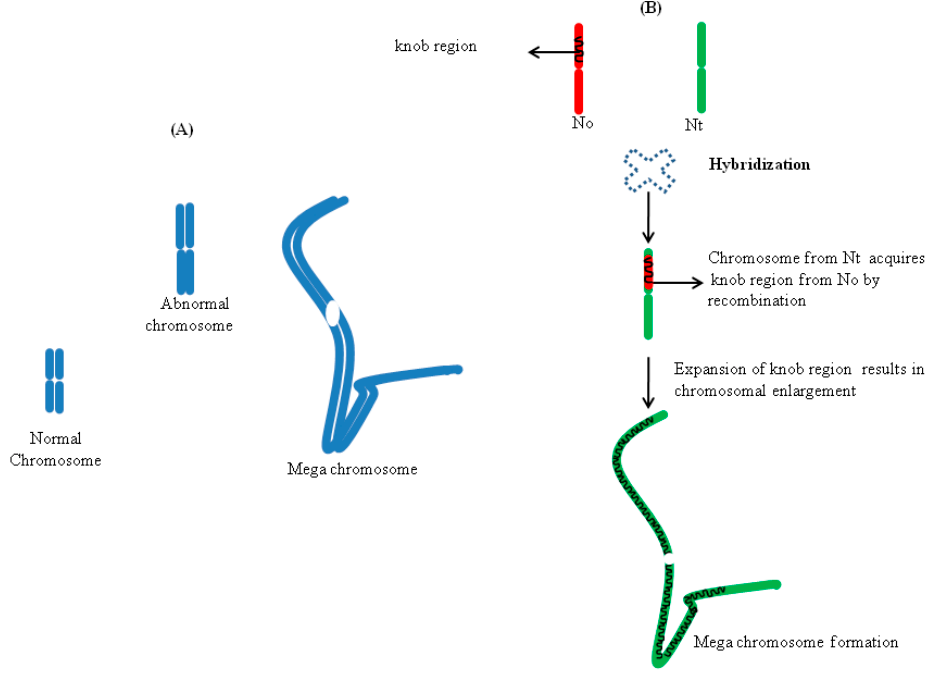
Figure 3. (A) Chromosomal size variations seen in Nicotiana allopolyploids. (B) Hybridization triggers transfer of the knob region (heterochromatinised DNA segment) via recombination from Nicotiana tabacum (N.t.) to Nicotiana otophora (N.o.) chromosomes. Subsequent expansion of the knob region results in chromosomal enlargement. Based on data from